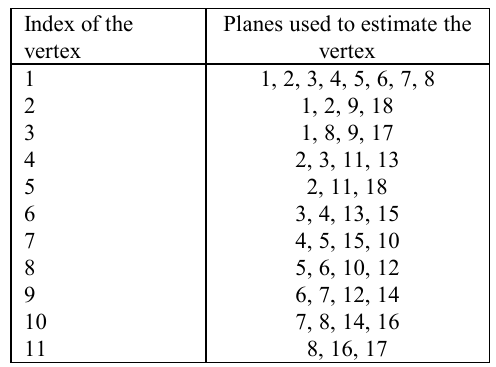
Figure 13. Graph diagram of the adjacency ordering for surface 2 of Scenario 3.